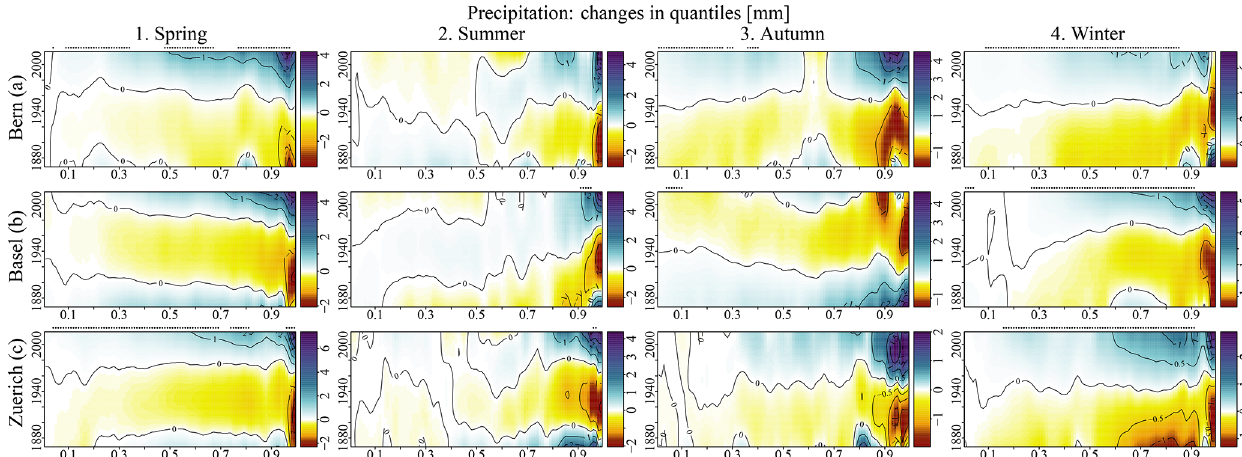
Figure C1. Changes in quantiles for individual seasons (spring: March–May, summer: June–August, autumn: September–November and winter: December–February) for precipitation measured at stations Bern (a) , Basel (b) and Zurich (c) . Points on top of the panels